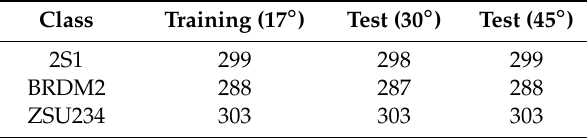
Table 6. Dataset for the depression angle test.